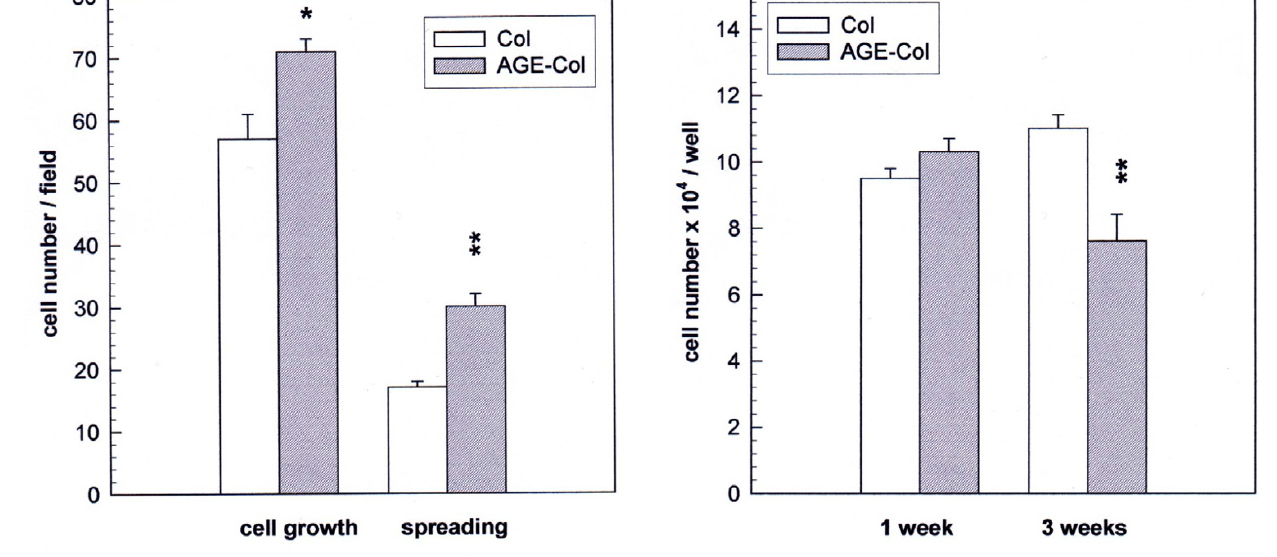
Figure 3 Effect of an AGE-modified type I collagen matrix on MC3T3E1 cell proliferation and spreading. MC3T3E1 osteob- lastic cells were cultured on an unmodified collagen matrix or an AGE-collagen matrix for 24 hours at 37 ° C. Cell prolif- eration was evaluated by microscopically counting cells stained with Giemsa, at a magnification of 400X. Cellular spreading was also estimated microscopically, as the number of cells possessing at least two corners. Results are given as the number of cells counted per field, and are expressed as the mean ± SEM. Differences between collagen vs. AGE-col- lagen are as follows: * p<0.01; ** p<0.001.